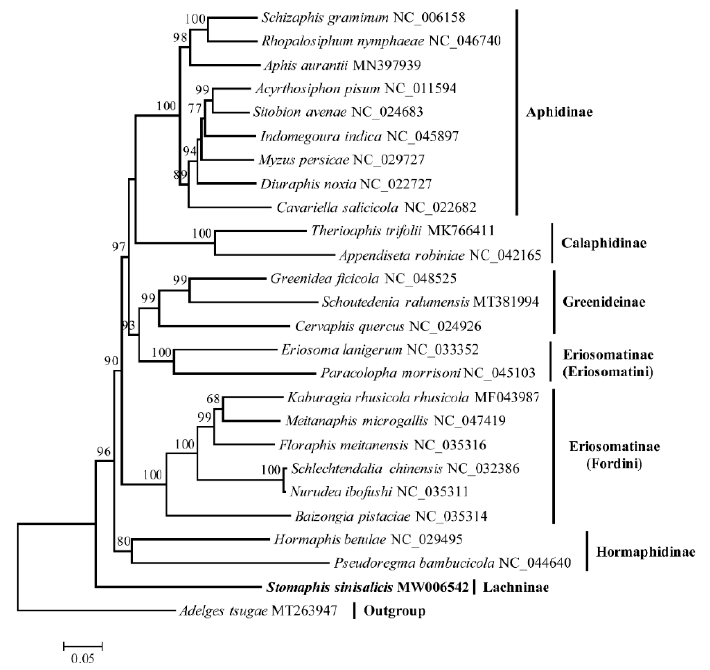
Figure 8. The maximum-likelihood phylogenetic tree based on 13 protein-coding genes of Stomaphis sinisalicis and 24 other aphids with the Adelges tsugae as outgroup. Bootstrap support values >50% are indicated above the branches.